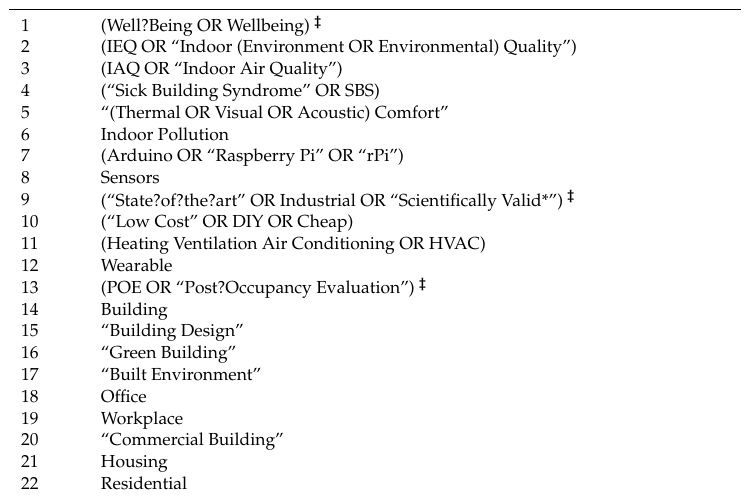
Table 1. List of Search Terms